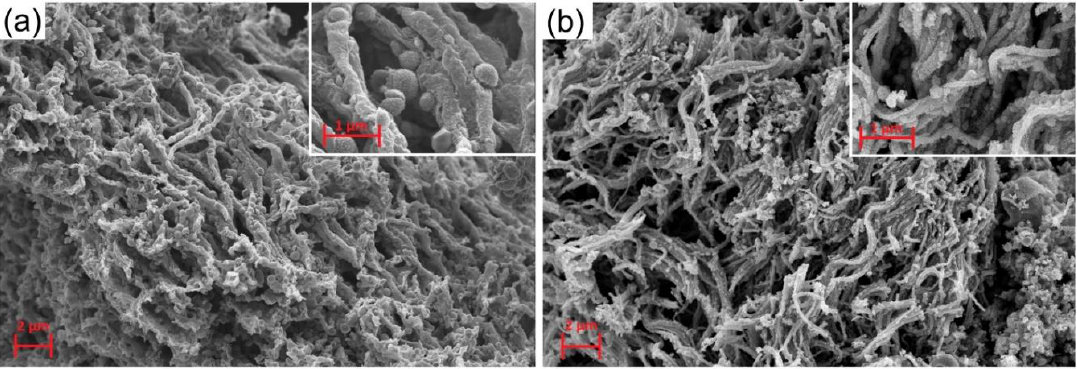
Figure 2. SEM images of ZnO ( a ) and ZnO/Pd ( b ) nanofibers.